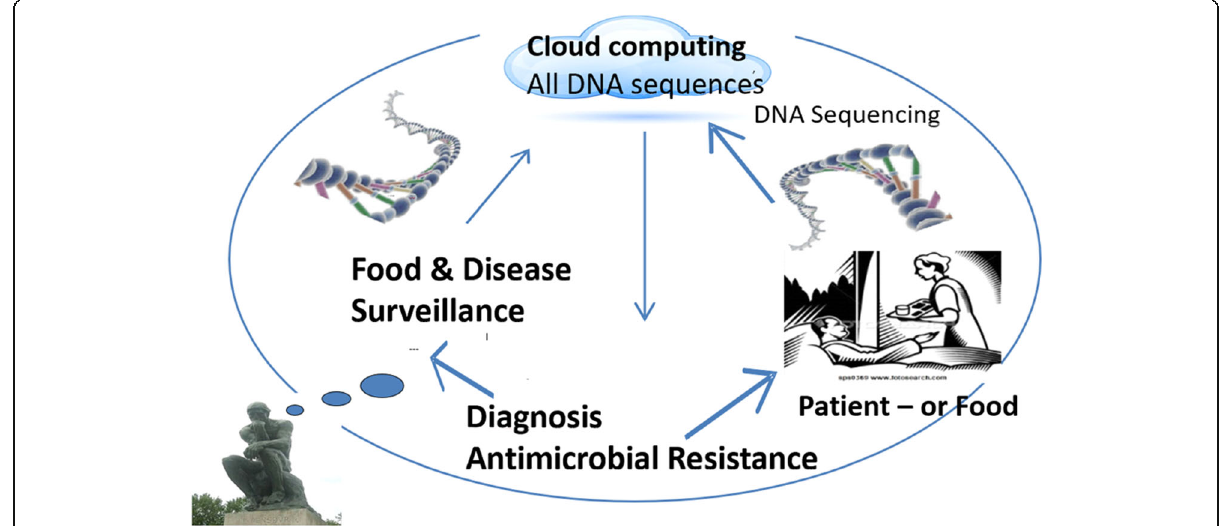
Fig. 9 In the future, a global system of DNA genome databases for microbial (and AMR) identification and diagnostics could be established, enabling a professional response to health threats for all countries with basic laboratory